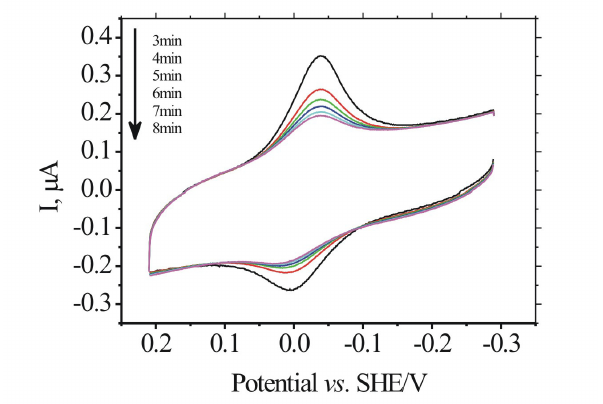
Figure 5. Cyclic voltammograms of ds-DNA/Au.in MB free E-buffer after incubated in 20 μ M MB for 20